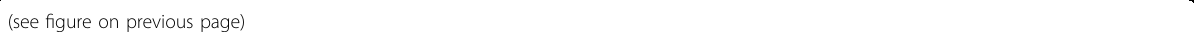
Fig. 6 BTK-KO dendritic cells are more mature and produce higher amount of Th1 polarizing cytokine in response to TLR stimulation. A Composition of innate immune cell populations in colon LP of WT and BTK-KO mice. Mono-derived macrophage: monocyte-derived macrophage. B Frequency of individual innate immune cell populations in CD45 + cells from colon LP of WT and BTK-KO mice. C – E Maturation and cytokine production of splenic DCs from WT and BTK-KO mice. Splenic CD11c + DCs from WT and BTK-KO mice were cultured in medium with or without 500 ng/ml CpG-ODN for 18 h. Expression of the indicated maturation markers on splenic DCs in response to CpG-ODN stimulation ( C ) was analyzed by fl ow cytometry. Data shown are representative of at least three independent experiments. IL-12p40 (upper) and IL-10 (lower) secretion from splenic DCs in response to CpG-ODN stimulation ( D ) was quanti fi ed by ELISA using known standards. IL-12 (upper) and IL-10 (lower) mRNA expression in splenic DCs in response to CpG-ODN stimulation ( E ) was analyzed by quantitative RT-PCR. GAPDH served as the internal control. F , G In vitro CD4 + T cell differentiation in DC-conditioned medium. Naïve CD4 + T cells were puri fi ed from spleen and MLNs of WT mice, followed by in vitro differentiation in medium prior conditioned by CpG-ODN-treated WT and BTK-KO DCs. After 5 days of differentiation, intracellular IFN- γ expression by differentiated CD4 + T cells ( F ) was analyzed by fl ow cytometry. IFN- γ secretion from differentiated CD4 + T cells into the culture supernatant ( G ) was quanti fi ed by ELISA using known standards. Data are presented as mean ± SEM [ n = 5 for D upper panel, n = 4 for D lower panel, n = 3 for ( E , G )]. Statistical signi fi cance was determined by two-sided independent sample Student ’ s t test. ns: not signi fi cant; * P < 0.05, ** P < 0.01 and *** P <